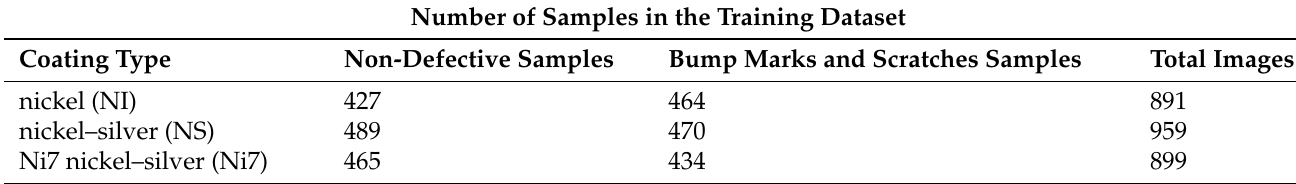
Table 1. Number of acquired training images for each coating and each defect type.